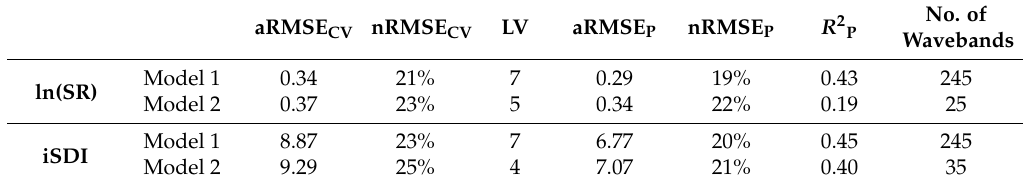
Table 1. Summary of the ability of PLSR models, based on spectral reflectance using the full set of wavebands (Model 1) or a subset of wavebands (Model 2), to predict the species richness (ln(SR)) and the inverse Simpson’s diversity index (iSDI). The cross-validated error of the calibration models ( n = 51) is indicated by the absolute (aRMSE CV ) and normalized RMSE CV (nRMSE CV , %). LV indicates the number of latent variables used in the PLSR models. The absolute and normalized prediction errors (aRMSE P , nRMSE P (%)) indicate the ability of the model to predict the observed species diversity measure. The squared correlation ( R 2P ) indicates the fit between the predicted and observed diversity values from the validation subset ( n = 51).